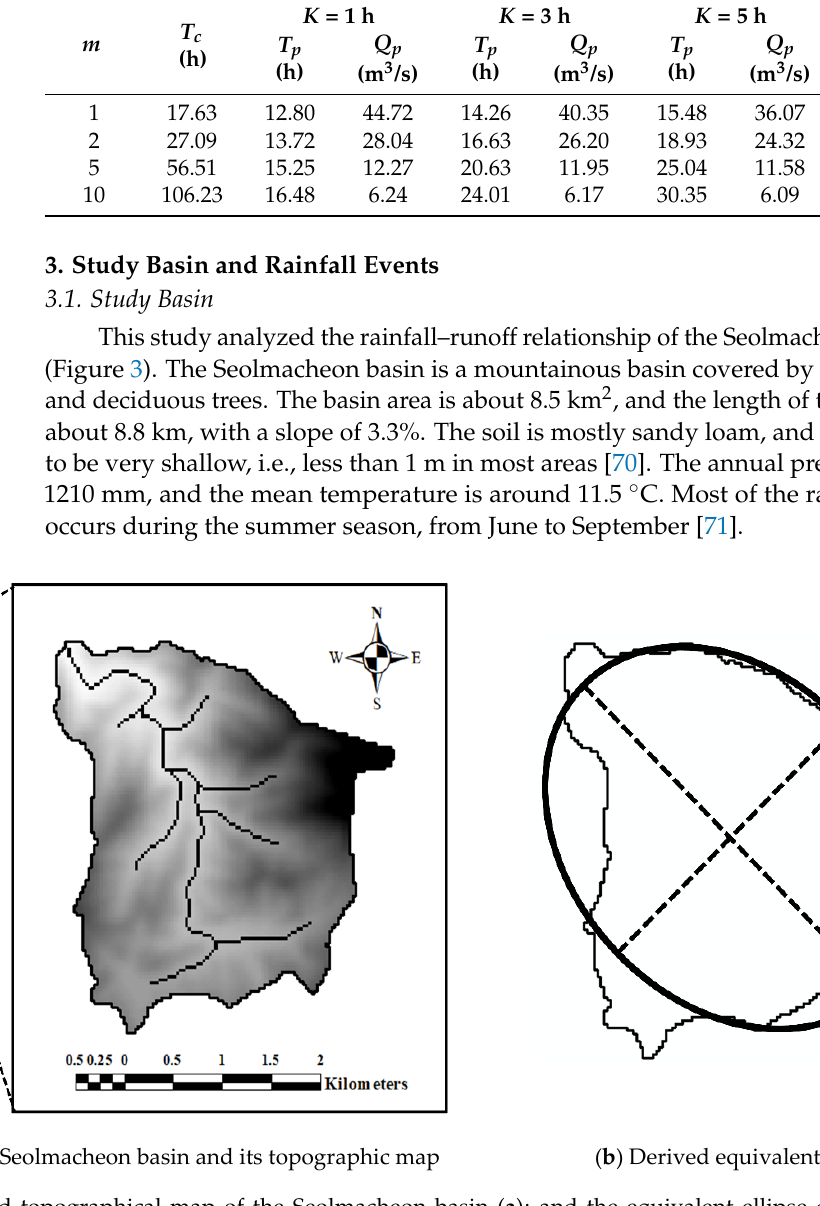
Figure 3. Location and topographical map of the Seolmacheon basin ( a ); and the equivalent ellipse derived for the Seolmacheon basin ( b ).